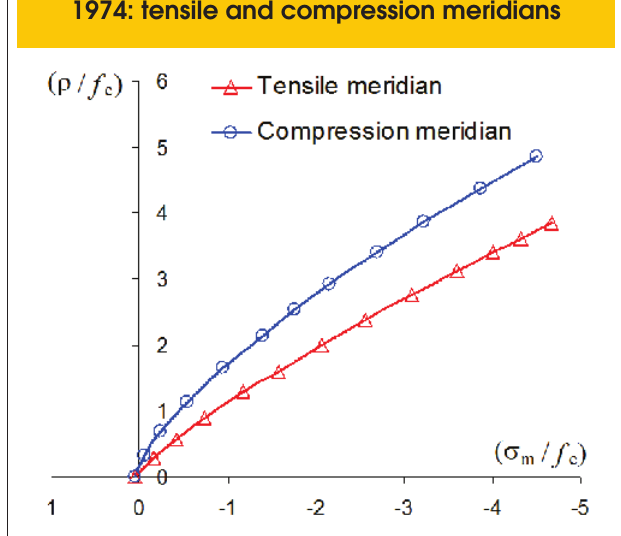
Figure 3 – The model by Willam and Warnke 1974: tensile and compression